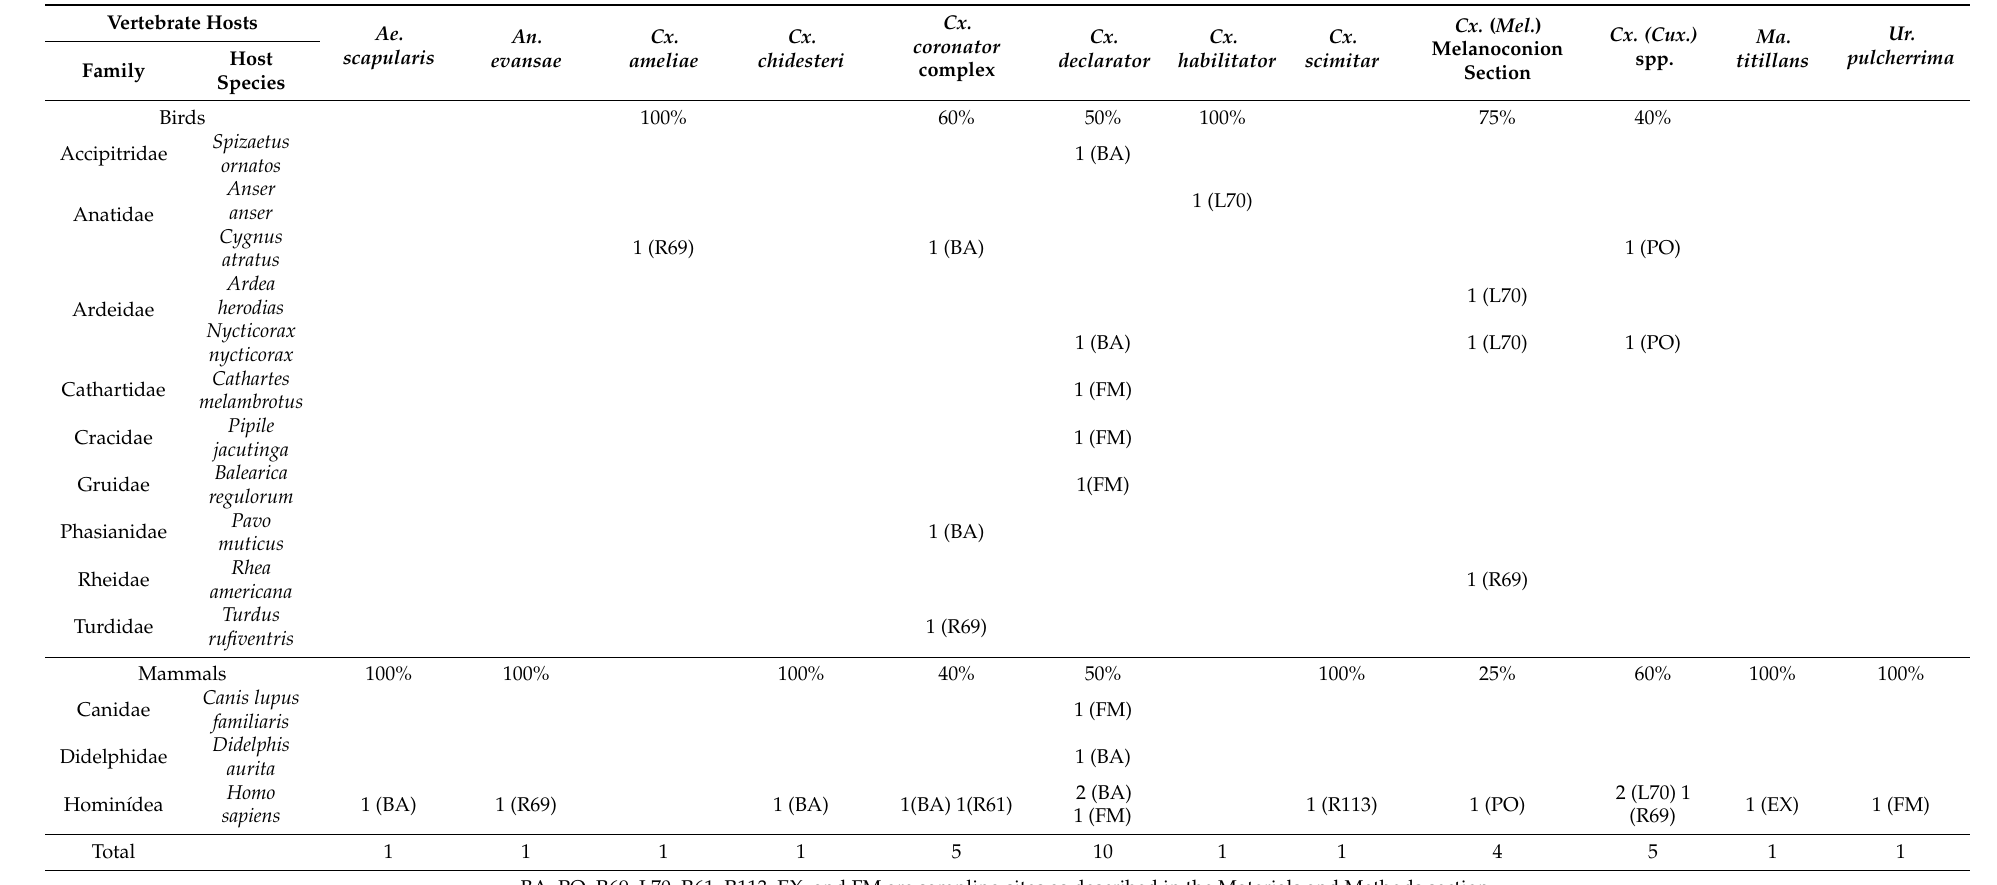
Table 4. Blood meal sources identified and number of engorged female mosquitoes from S ã o Paulo